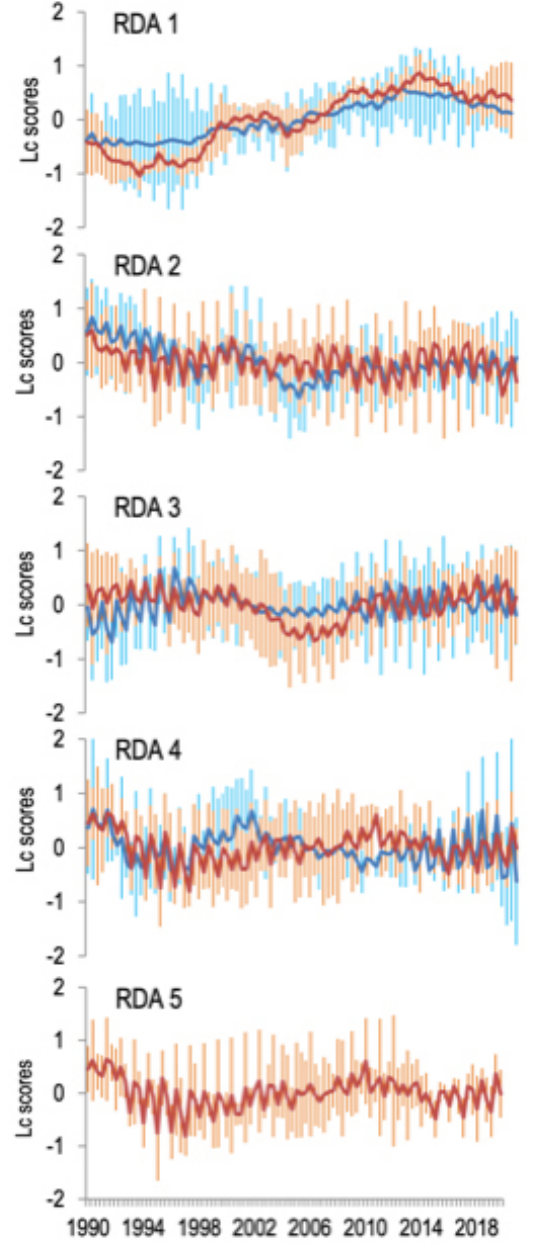
Fig. 3 . Linear combination (lc) score plots showing distinct temporal patterns modeled by RDA analyses. These temporal patterns correspond to different scaling patterns indicative of hierarchical and orthogonal structuring of lake panarchies. Shown are the averages ± standard deviations of four reference (blue lines) and limed (red lines) lakes; except RDA 4, which is based on the average of three reference lakes and RDA 5, which was significant only in three limed lakes (See Table